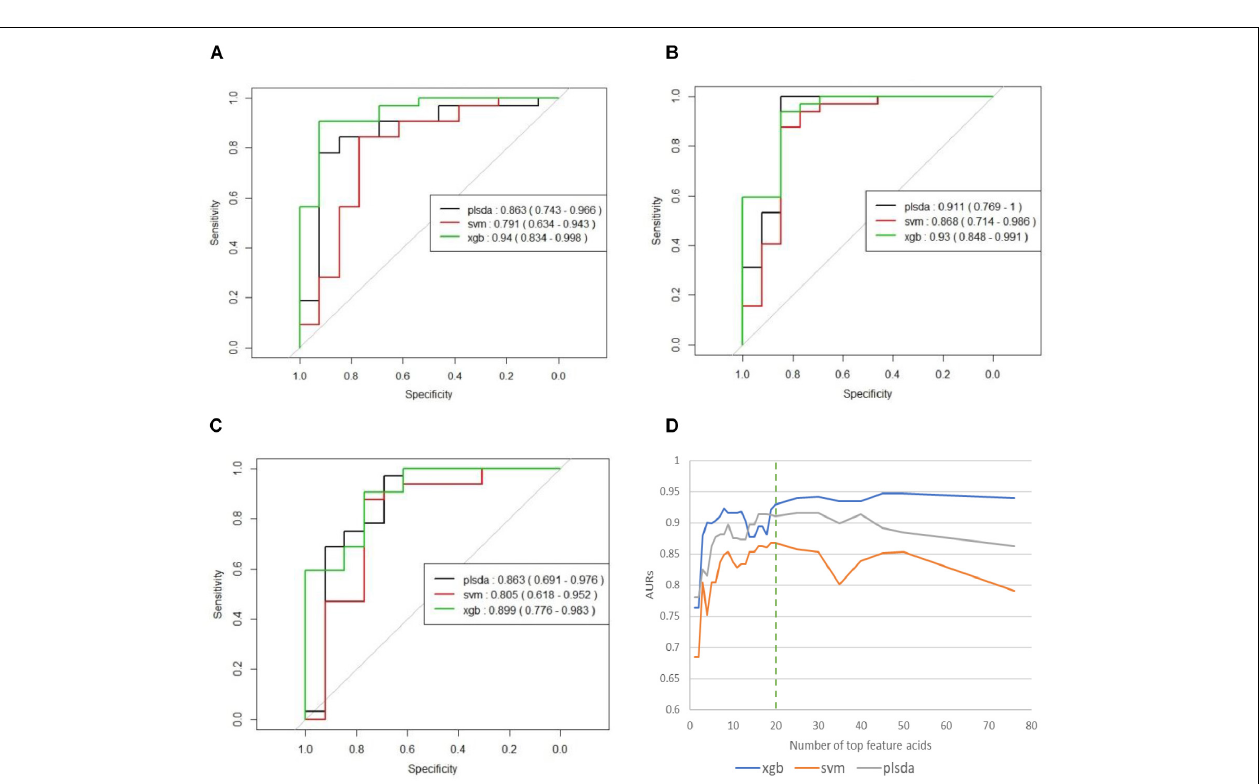
FIGURE 3 | (A) ROCs of final models on independent testing set based on all 76 organic acids. (B) ROCs of final models on independent testing set based on top 20 organic acids. (C) ROCs of final models on independent testing set based on top five organic acids. (D) Curves of AURs against selected top acids. Top 20 acids represent the best collection of possible ASD biomarkers, while adding more will make AURs for SVM and PLS-DA decrease and make AUR for XGB appear